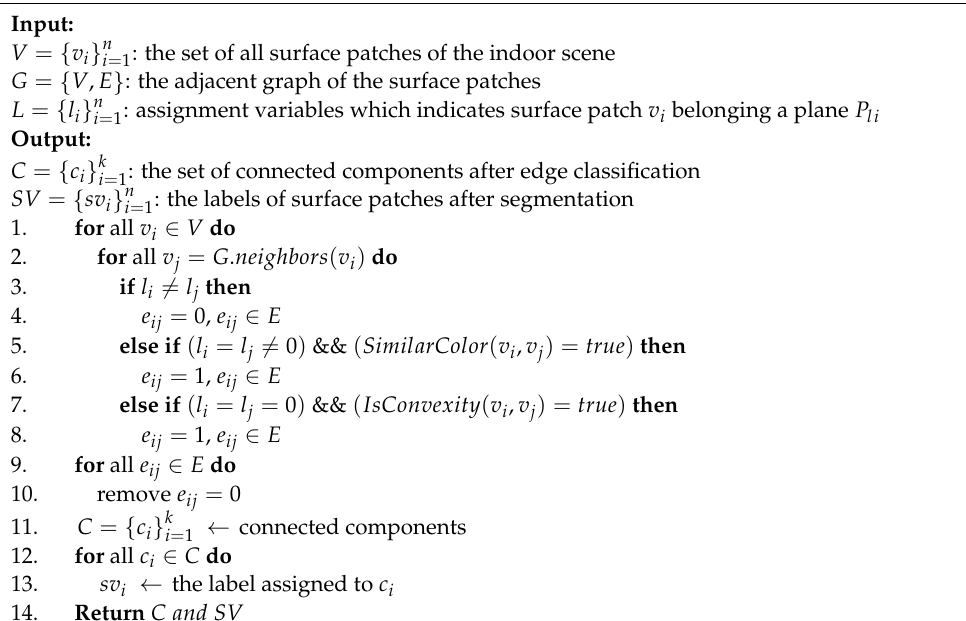
Algorithm 2 . Multi-Constraint Graph